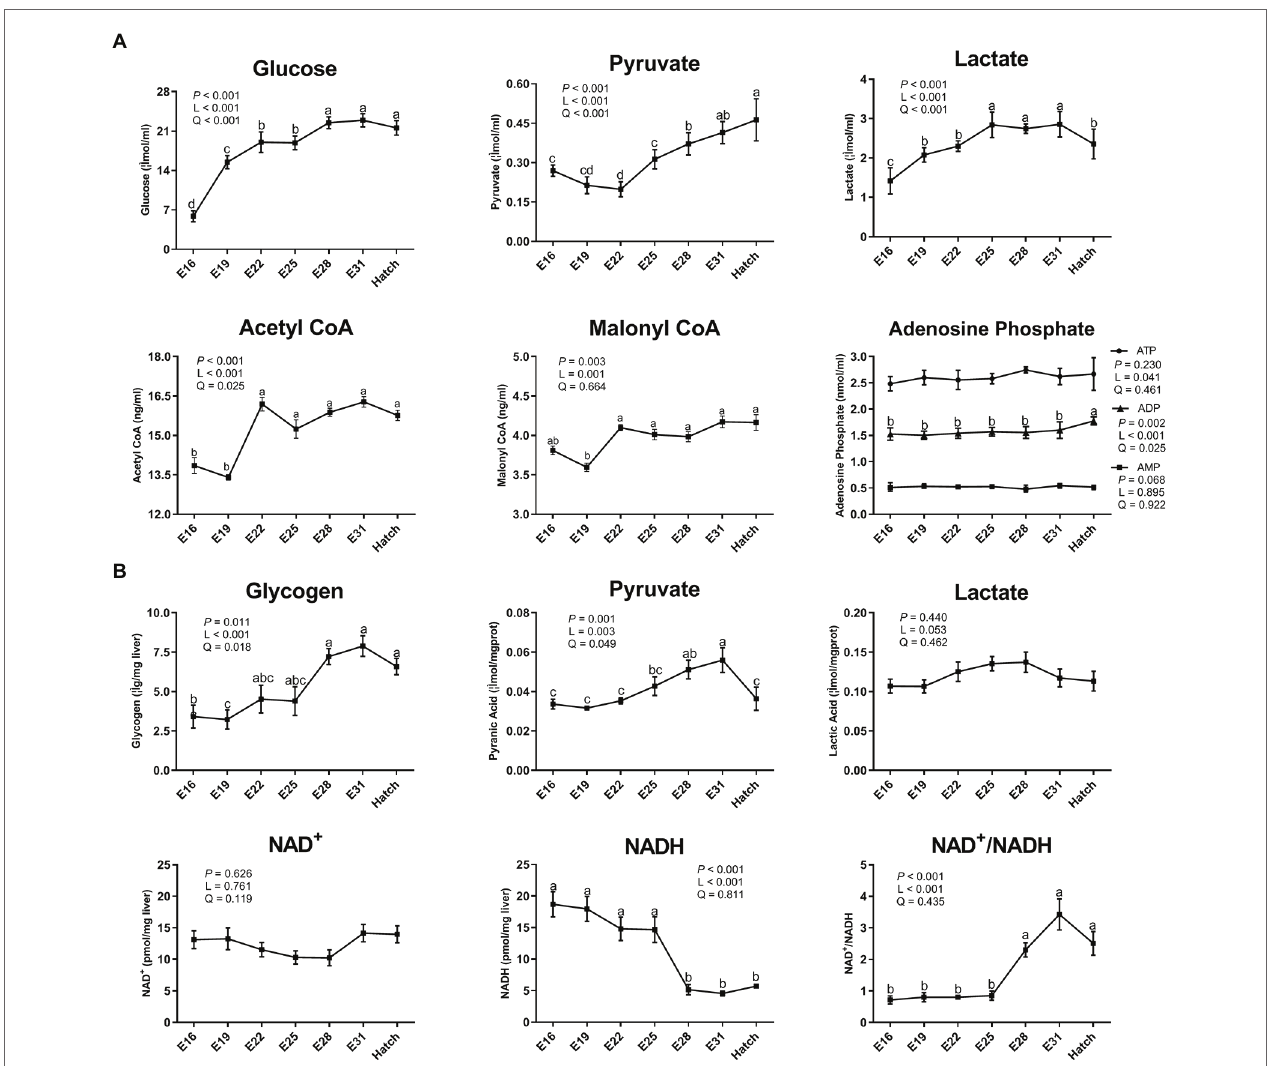
FIGURE 1 | Dynamic changes of serum and hepatic biochemical index in the avian model. (A) serum biochemical index; (B) hepatic biochemical index. Abbreviations: CoA, coenzyme A; ATP, adenosine triphosphate; ADP, adenosine diphosphate; AMP, adenosine monophosphate; NAD, nicotinamide adenine dinucleotide; NAD + , the oxidated form of NAD; NADH, the reduced form of NAD. Data are expressed as mean ± SEM ( n = 6), and values on the same line with different lowercase letters indicated statistically significant differences (one-way ANOVA, P < 0.05). L, linear; Q,